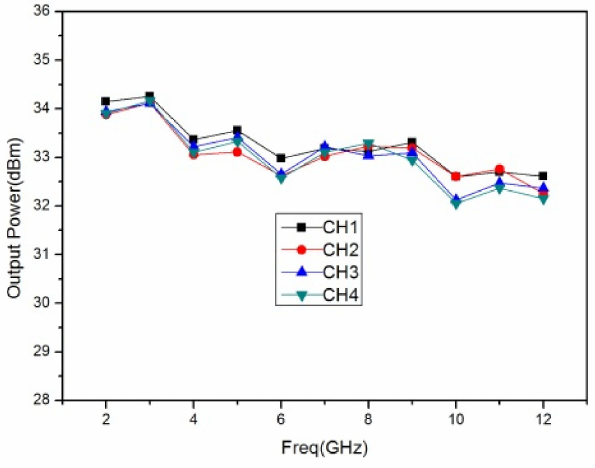
Figure 14. Transmit output power.